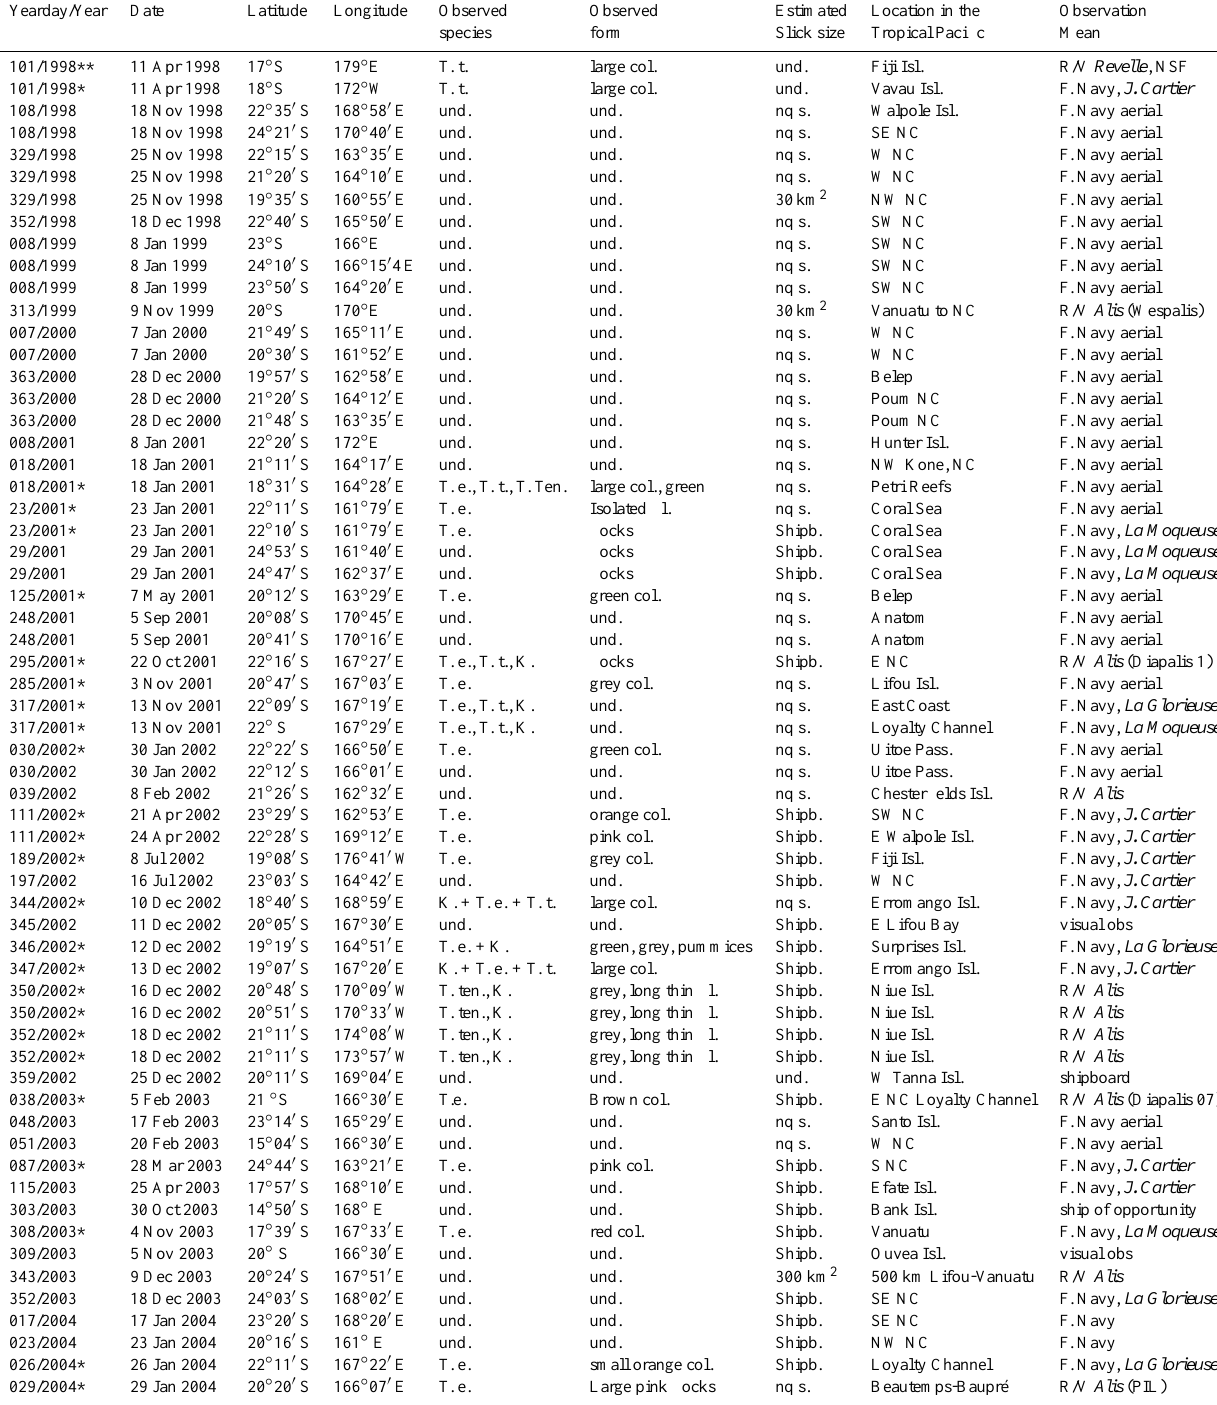
Table 1. In situ Trichodesmium bloom observations for the period 1998–2010 in the South Western Tropical Pacific (NC, New Caledonia). Data from aerial observations, and/or bucket sampling from cruises and various transects made by the French Navy ships and the R/V Alis